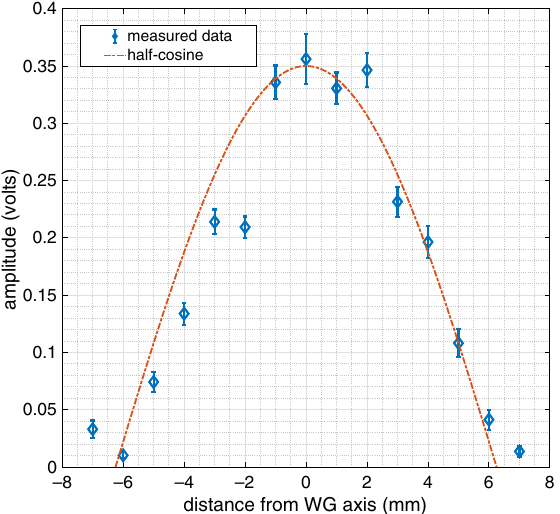
FIG. 12. Cross-covariance coefficient for each channel 3 wave- form in the offset data sample vs the CH3 template waveform.